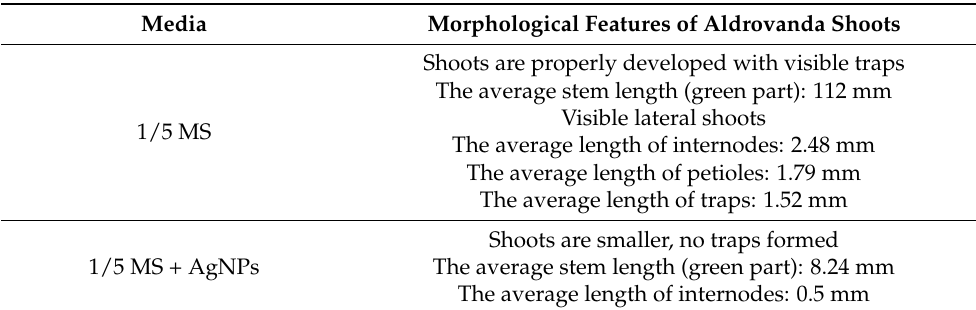
Table 2. Morphological features of the regenerating explants of Aldrovanda vesiculosa , depending on the addition of AgNPs to the 1/5 MS culture media.